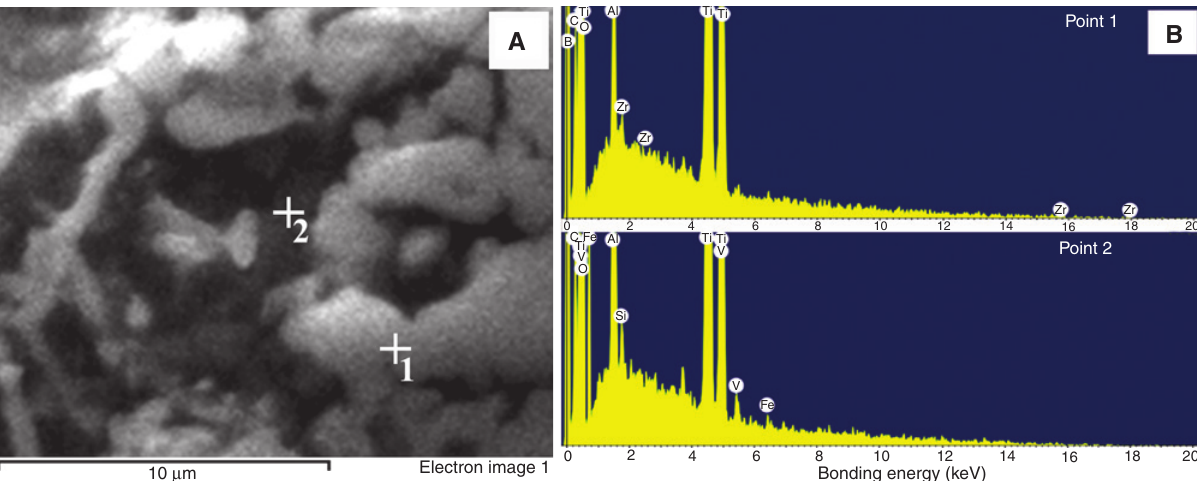
Al-B C-YPSZ-Al O laser clad composites and the EDS spectrum analysis, (A) microstruc- 3 4 2 3 Al-B C-YPSZ- 3 4